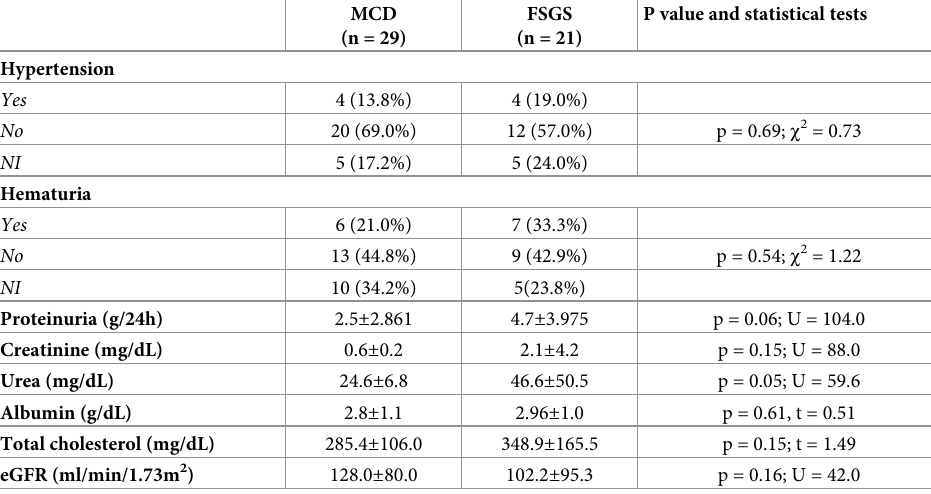
Table 2. Clinical and laboratorial data of patients with FSGS and MCD.